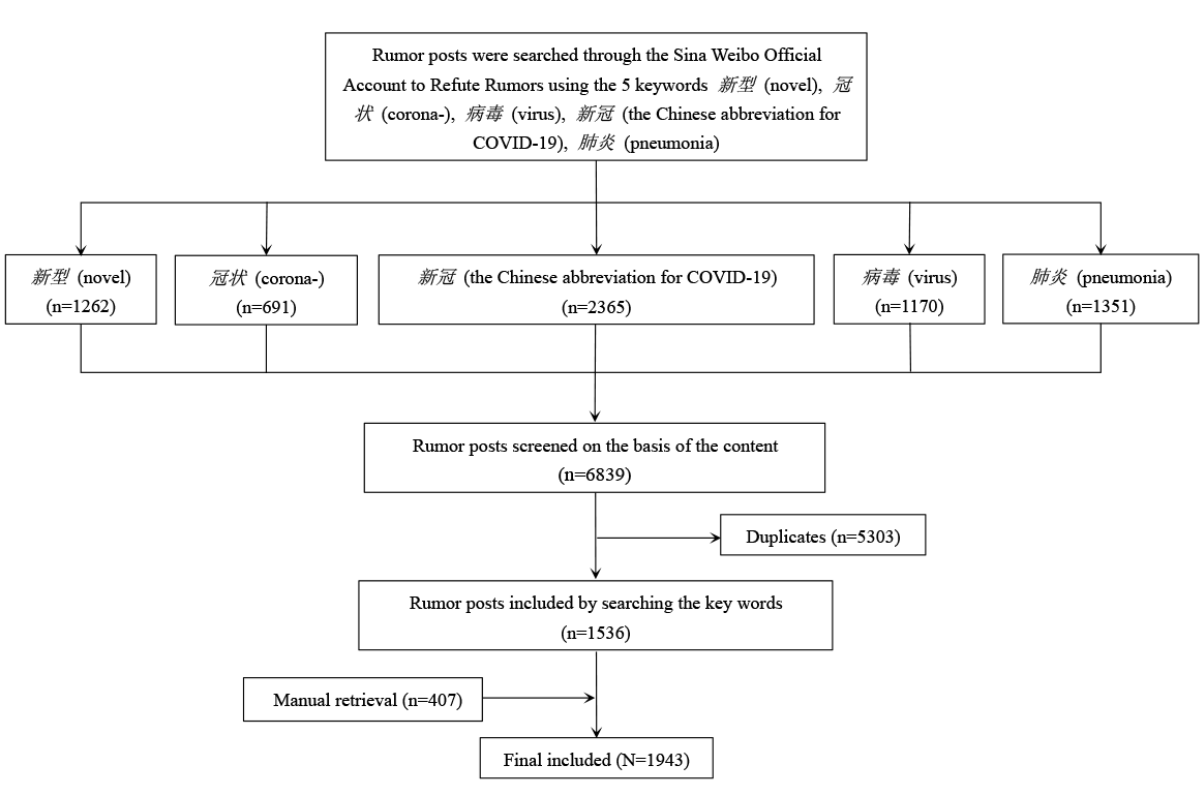
Figure 1. Flowchart of the selection of rumor